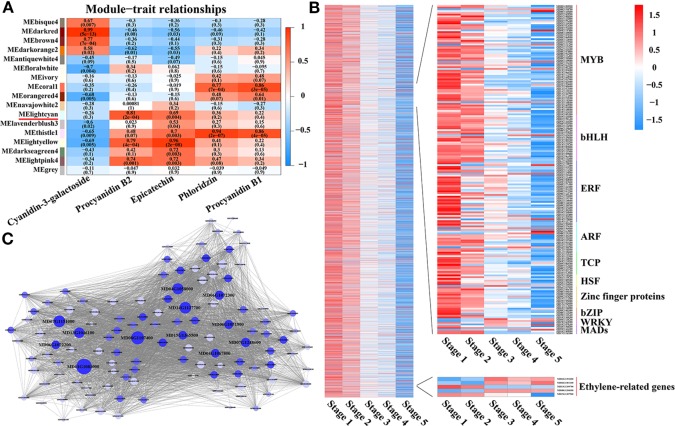
Identification of WGCNA modules and hub genes associated with proanthocyanidin biosynthesis. (A) Module-PA weight correlations and corresponding P-values (in parentheses). A high degree of correlation between a specific module and the procyanidin B2 is indicated by red underlining of the module name. (B) Transcriptional heat map of genes in the MElightcyan module, the module with the highest correlation with procyanidin B2. (C) Analysis of TF correlation networks in the MElightcyan module. Candidate hub genes are shown in bigger font, and the size of the graph is positively correlated with the PA correlation. Different letters above the bars indicate significantly different values (P < 0.05) calculated using one-way analysis of variance (ANOVA) followed by Tukey’s multiple range test.